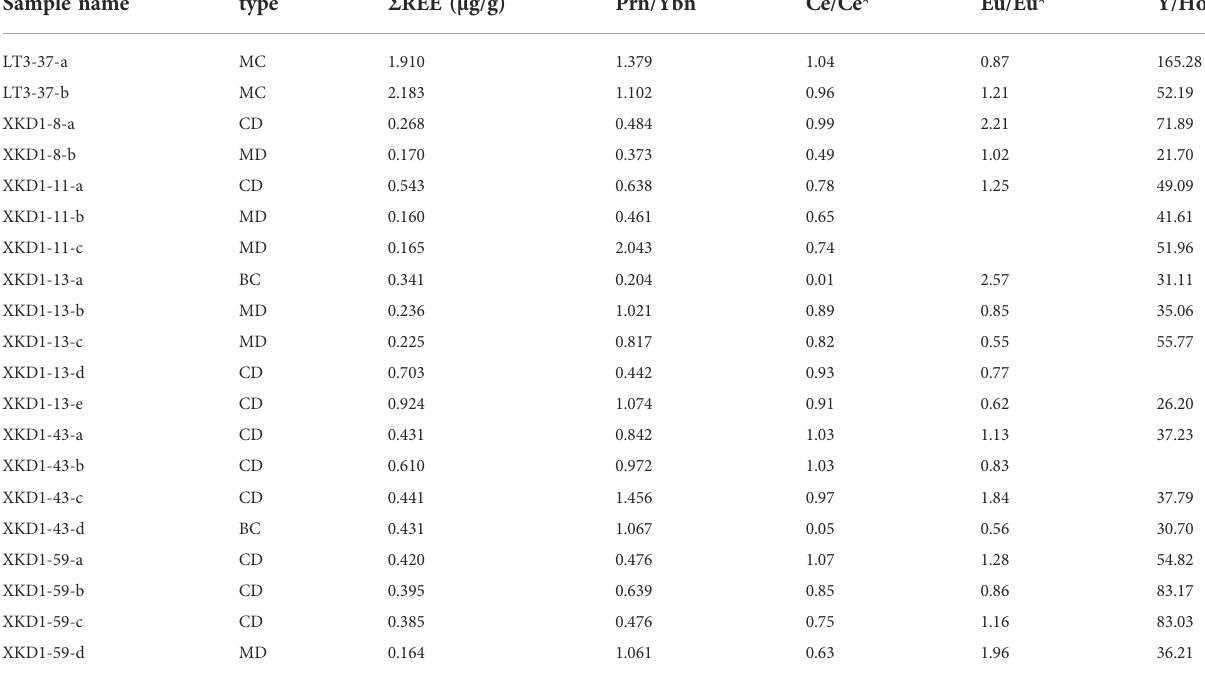
TABLE 2 REE + Y results of the Xiaoerbulake